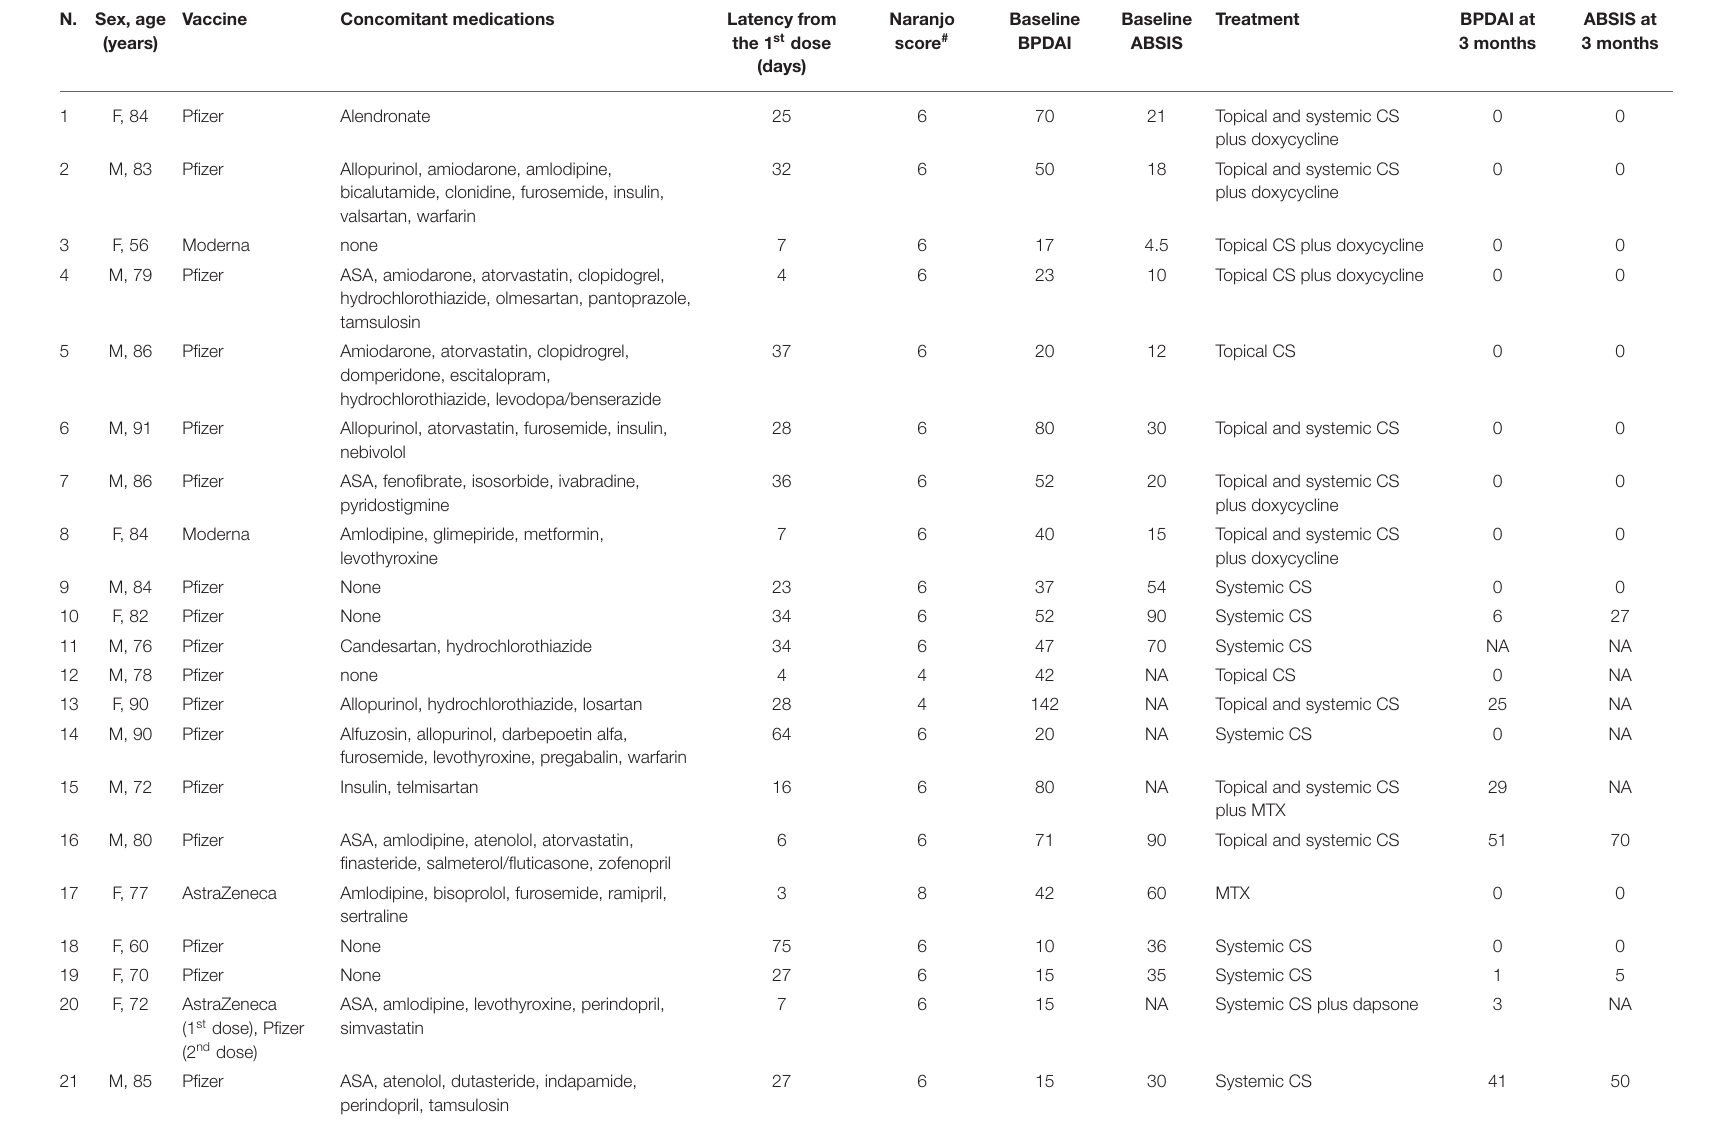
TABLE 1 | Demographics and clinical features of reported